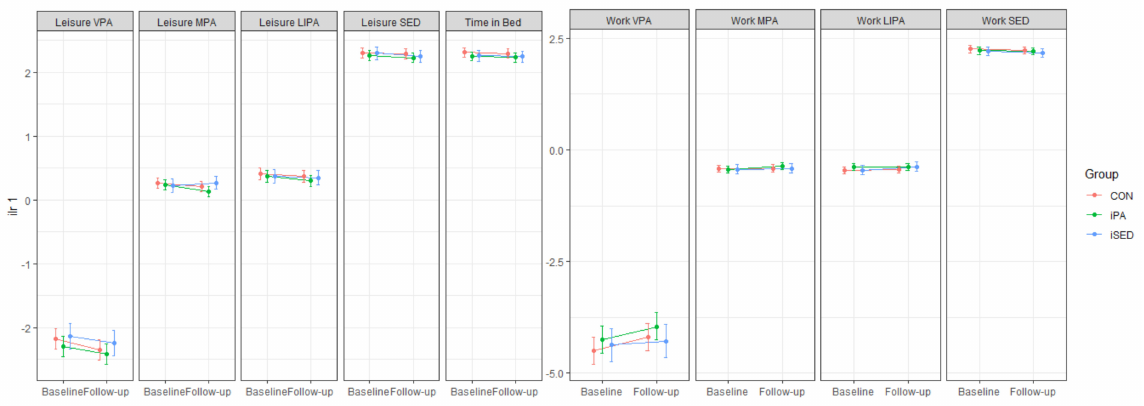
Figure 4. Marginal means (with 95% CI) for each domain-specific movement behavior, expressed in terms of ilr 1 (time spent in that behavior relative to time spent in all other behaviors) at baseline and 6-month follow-up with 95% CI bars. Values were estimated based on the results in the linear mixed models. VPA: vigorous-intensity physical activity, MPA: moderate-intensity physical activity, LIPA: light-intensity physical activity, SED: sedentary behavior. iPA: Intervention group focused on increasing physical activity, iSED: Intervention group focused on reducing sedentary behavior, CON: Control